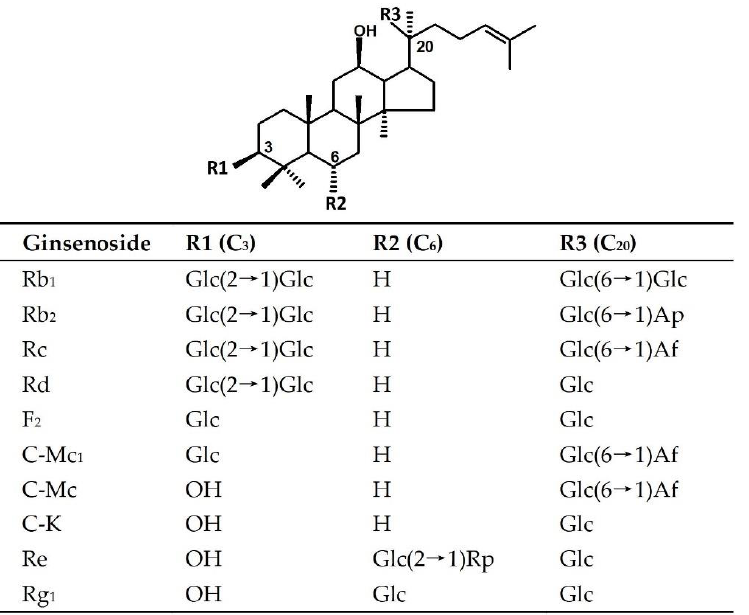
Figure 1. Chemical structure of ginsenoside Rb 1 , Rb 2 , Rc, Rd, Re, Rg 1 , F 2 , C-K, C-Mc, and C-Mc 1 . Glc, Ap, Af, and Rp are abbreviations of glucopyranosyl, arabinopyranosyl, arabinofuranosyl, and rhamnopyranosyl, respectively.